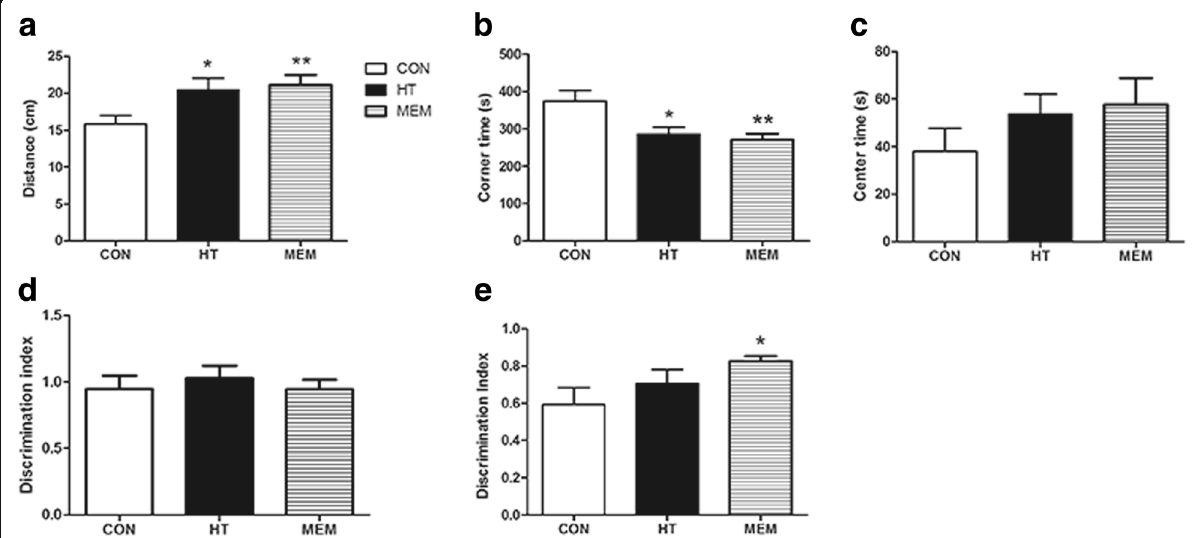
Fig. 2 HT ameliorates cognitive impairment in APP/PS1 Transgenic Mice. a Total distance in the open field test. b Corner times in the open field test. c Center times in the open field test. d Discrimination index during acquisition memory phase (training) during the novel object recognition test, showing no significant differences between the different groups. e Discrimination index for novel-object recognition during the retention memory phase (test). HT and MEM could rescue memory deficits and relieve anxiety in APP/PS1 mice. Values are expressed as the mean ± SEM n = 15 in each group; * P < 0.05 compared to the control group; ** P < 0.01 compared with control